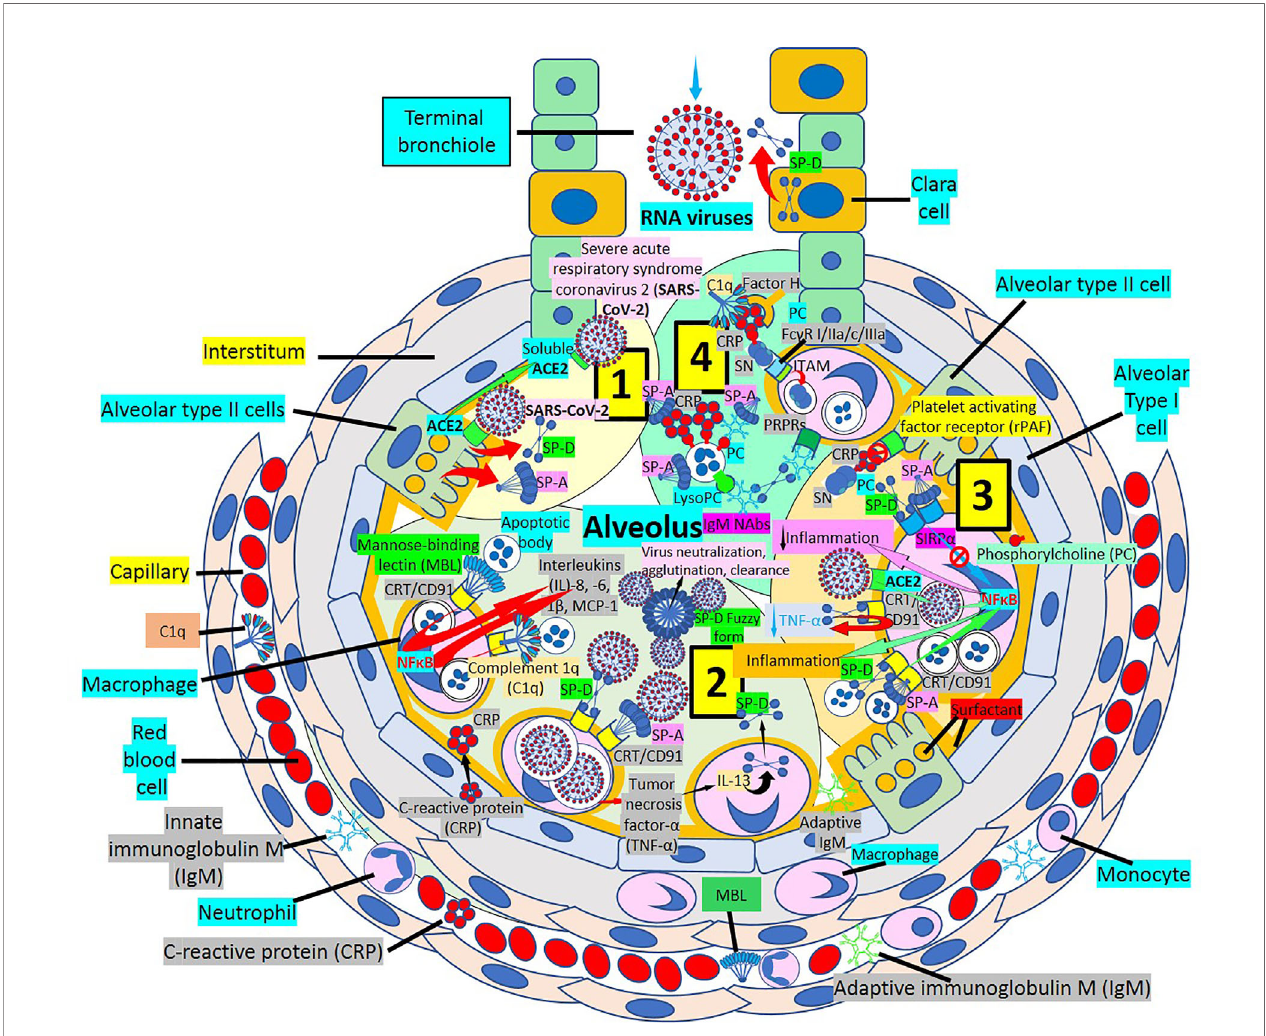
FIGURE 3 | Alveolar surfactant protein innate immune response to RNA viruses. [1] Intra-alveolar RNA viruses are exposed to surfactant proteins (SP)-A and -D produced by alveolar type II (AII) and Clara cells. SARS-CoV-2 binds ACE2 receptors in AII cells releasing soluble ACE2 to protect AII cells against SARS-CoV-2 infection. [2] MBL and C1q bind calreticulin/CD91 (CRT/CD91) receptors enhancing apoptotic body macrophage uptake and nuclear factor k B (NF k B)-mediated intra-alveolar release of IL-1ß, -6, -8 and monocyte chemoattractant protein-1 (MCP-1). CRT/CD91 bound SP-A and SP-D facilitate virus phagocytosis. TNF- a release stimulates IL-13-mediated SP-D macrophage output; and SP-D fuzzy form contributes to virus neutralization, agglutination and clearance. Circulating innate and adaptive IgM, MBL, C1q and CRP; and alveolar type I cell CRP synthesis and release contribute to alveolar immune defense. [3] CRT/CD91-bound SP-A and SP-D facilitate apoptosis and activate NF k B-mediated in fl ammation. Macrophage ACE2 facilitates virus uptake and SP-D-CRT/CD91 binding reduces TNF- a release. Signal inhibitory regulatory protein a (SIRP a ) SP-A and SP-D binding inhibits in fl ammation. Native CRP blocks PC-mediated attachment of streptococcus pneumoniae (SN) to rPAF on alveolar epithelial cells. PC is a main component of alveolar surfactant. [4] Interaction of SP-A, SP-D, CRP and IgM natural antibodies (NAbs) with apoptotic cells facilitate macrophage uptake through pattern recognition protein receptors (PRPRs). CRP bound to C1q and factor H mediates SN uptake via Fc g receptors and cytoplasmic immuno-tyrosine activating motif (ITAM)